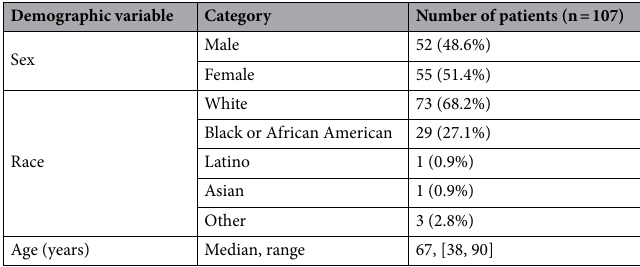
Table 3. Patient demographic information.